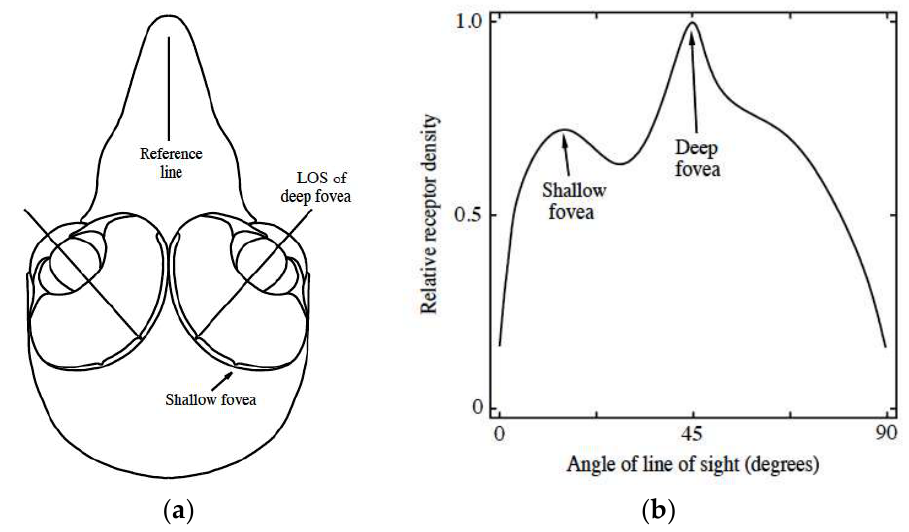
Figure 2. ( a ) Schematic of a generic raptor head showing the locations of the two foveae in the eye. The line of sight for the deep fovea is shown. The line of sight for the shallow fovea is pointed forward toward the beak of the raptor [27]; ( b ) Visual acuity as measured for a Chilean Eagle. The labeled regions of relatively higher acuity are the result of the foveae in the raptor eye. Human eyes have only one central peak [27].